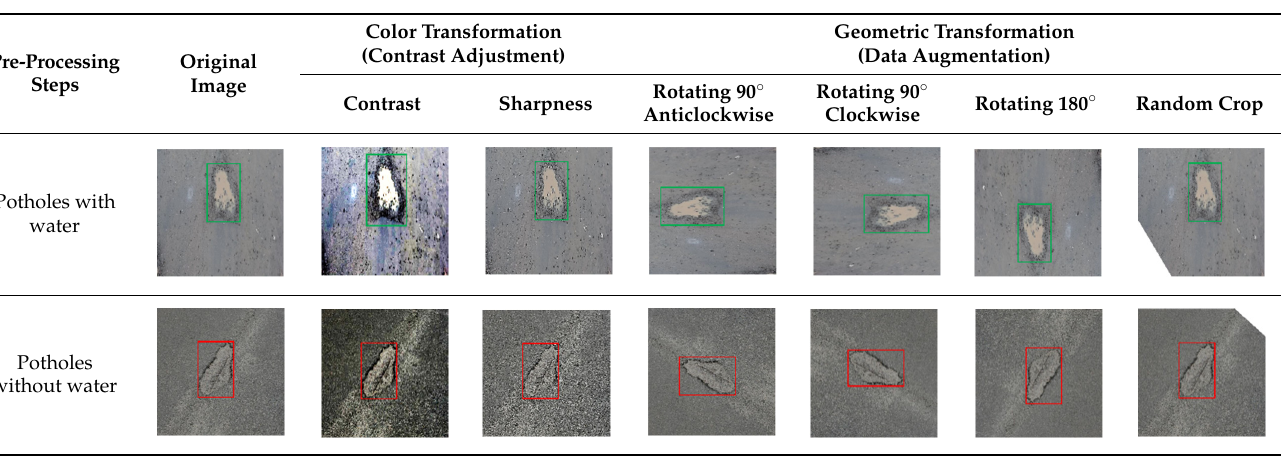
Table 3. Examples of data augmentation of pavement potholes.